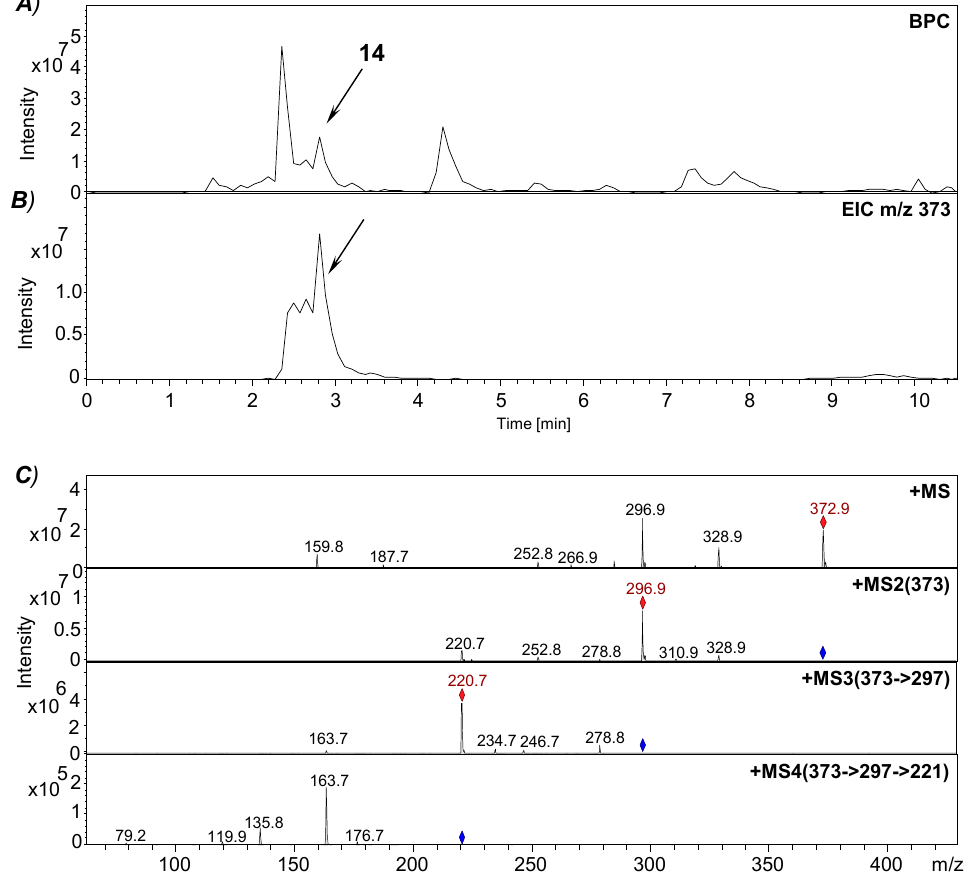
Figure 8. Detection of isochrysohermidinic acid ( 14 ) after enrichment from an unfermented aqueous M. perennis root extract by anion exchange chromatography. ( A ) Section of an LC-MS profile (BPC, positive ionization mode). ( B ) Extracted ion chromatogram (EIC) for [M+H] + at m/z 373. ( C ) Fragmentation of 14 (C 14 H 16 N 2 O 10 ; Mw 372.28 Da).